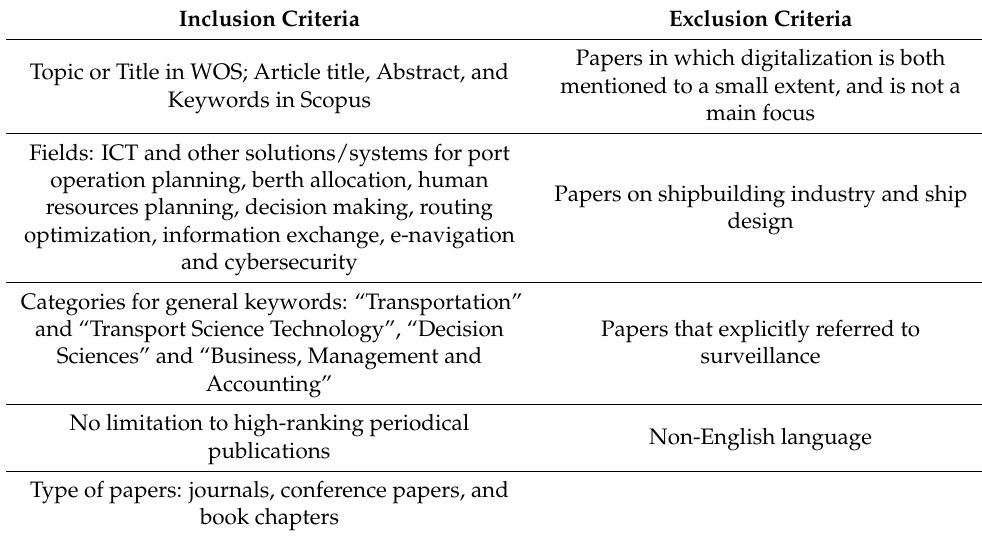
Table 1. Inclusion and exclusion